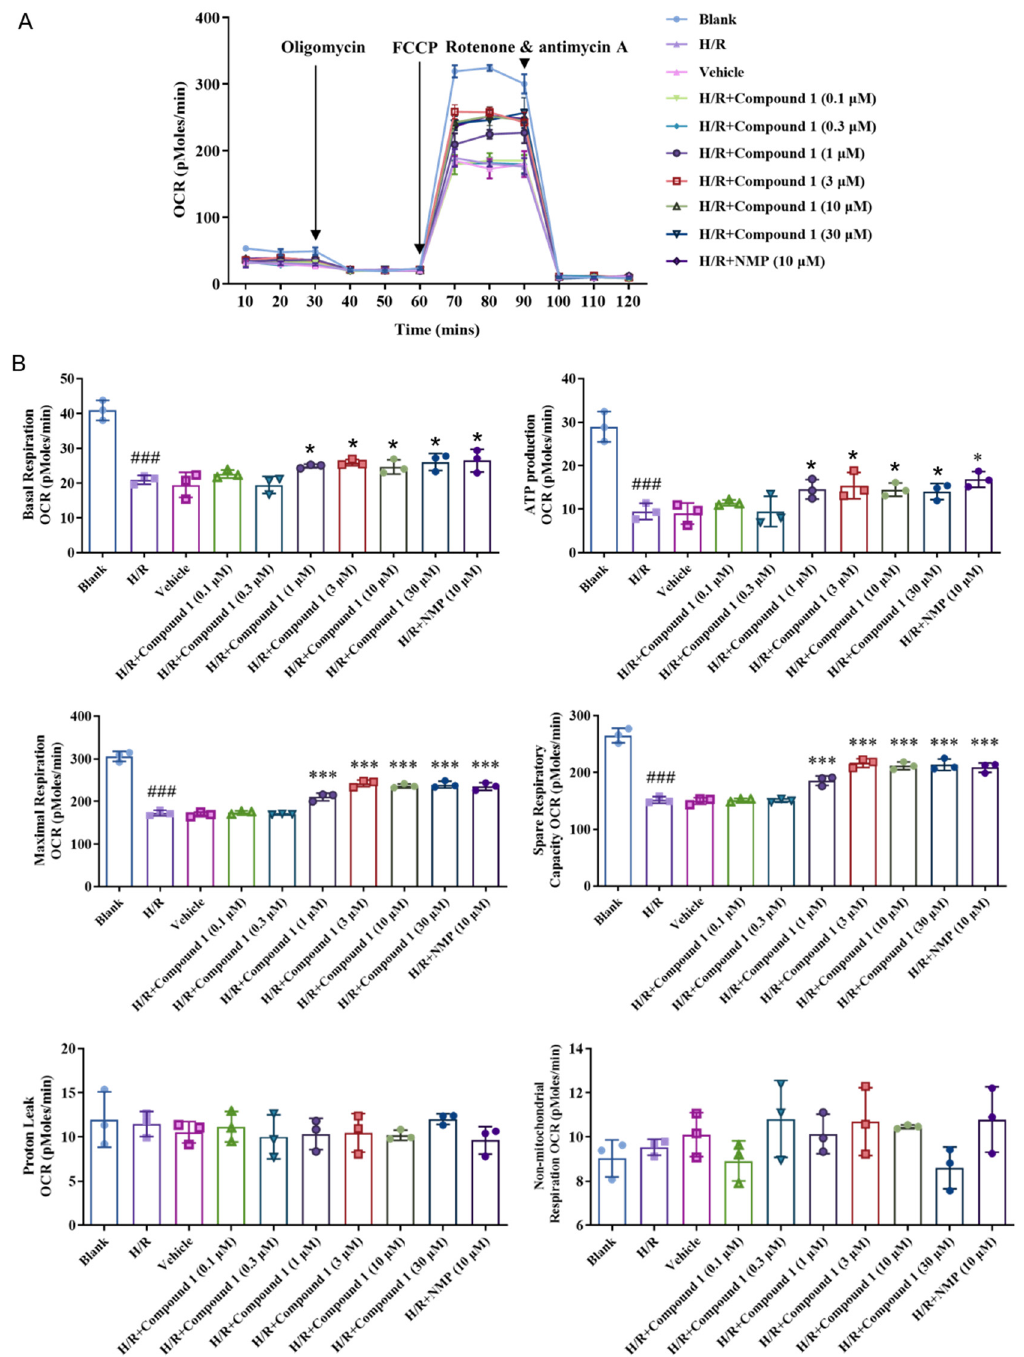
Figure 6. ( A ): Average oxygen consumption rate (OCR) values. ( B ): Bar graphs of Basal Respira- tion, ATP Production, Maximal Respiration, Spare Respiratory Capacity, Proton Leak, and Non- mitochondrial Respiration. Data represent mean ± SD (* p < 0.05, *** p < 0.001, vs. H/R Group; ### p < 0.001, vs. Blank